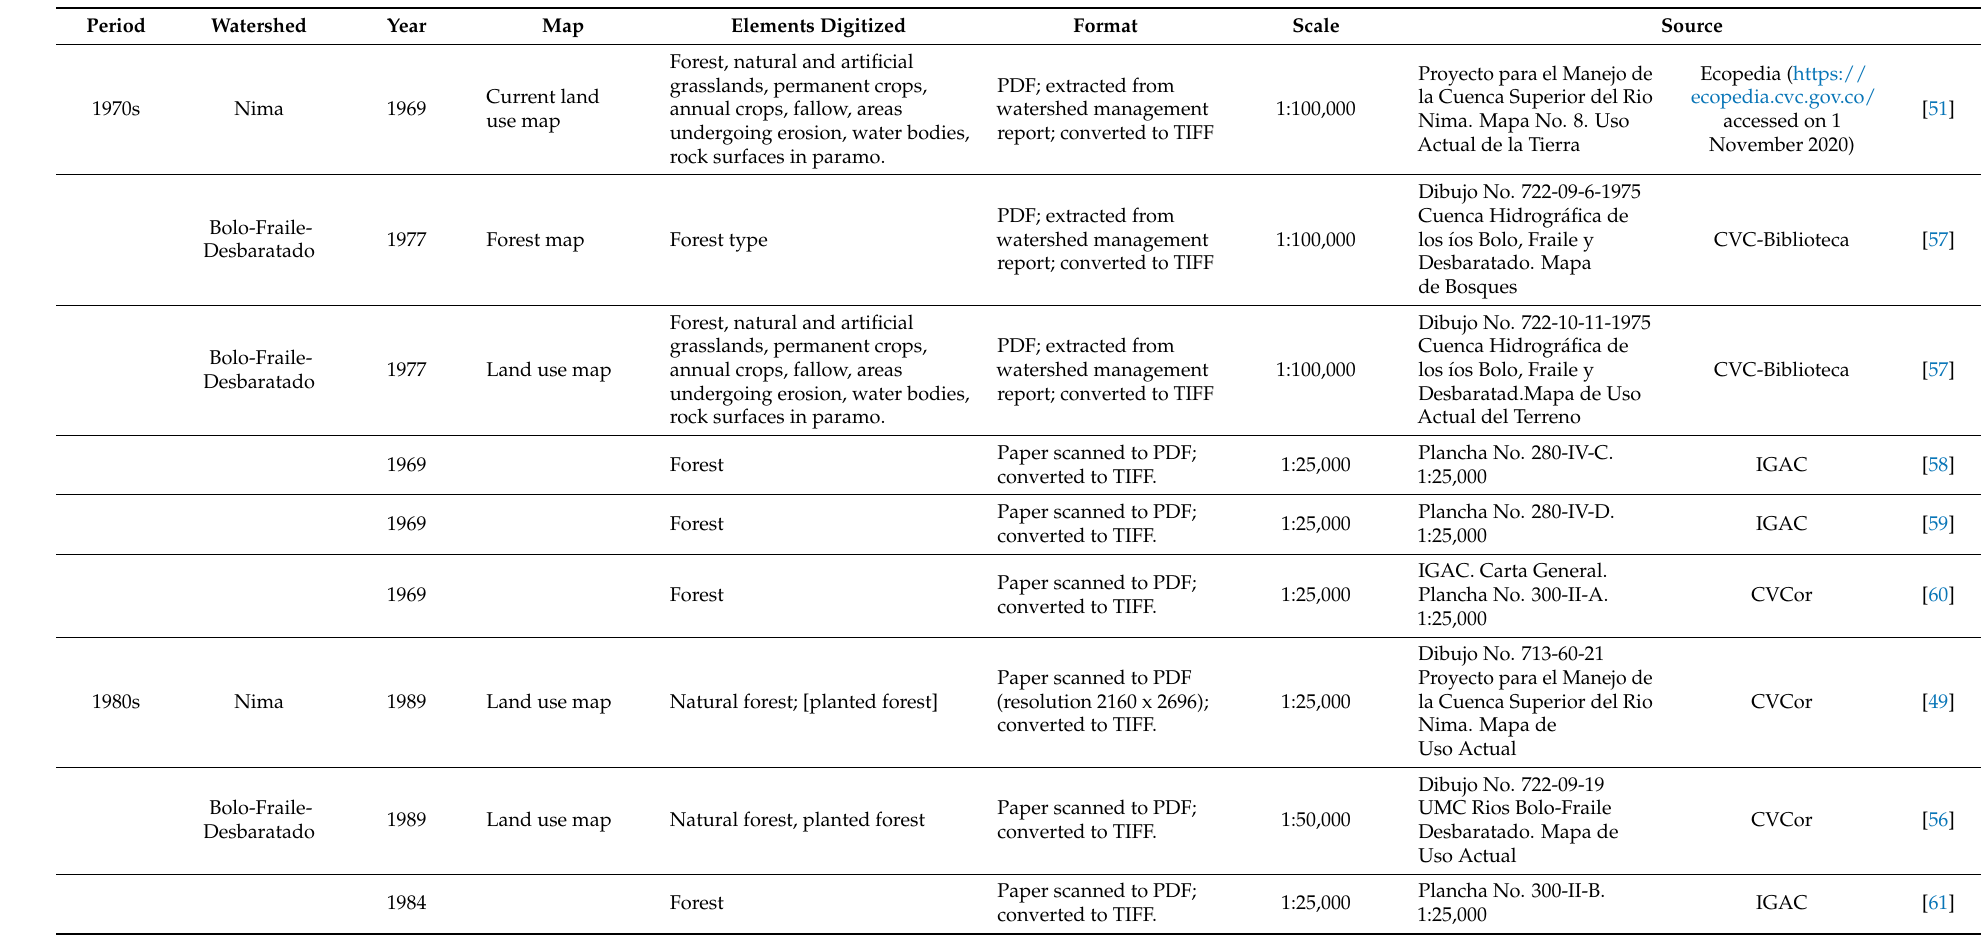
Table 1. Historical datasets, including, elements digitized, original formats, scale, and sources.